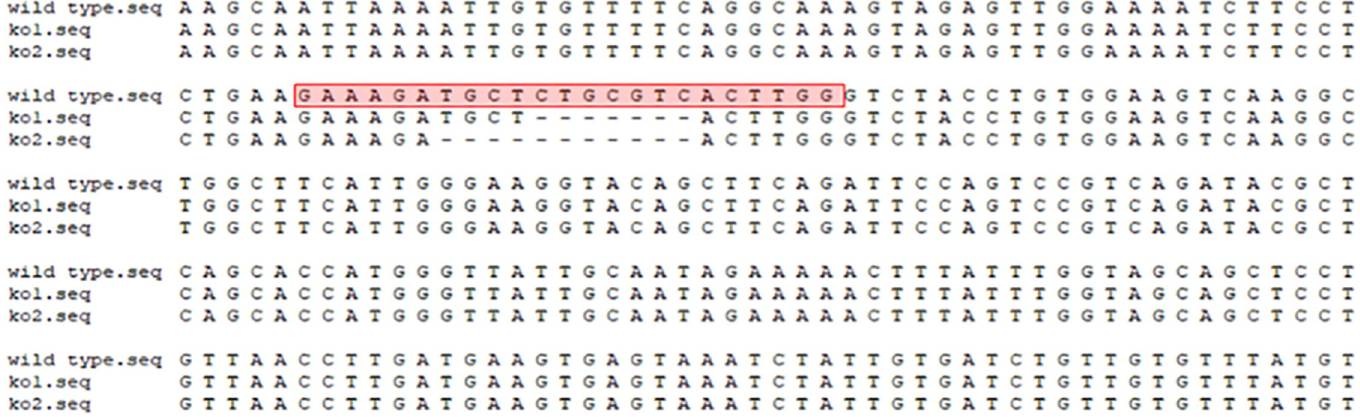
males of Δ BmVps13d showed 2.4% and 2.9% declines in the cocoon layer ratio respectively (Fig 7B).